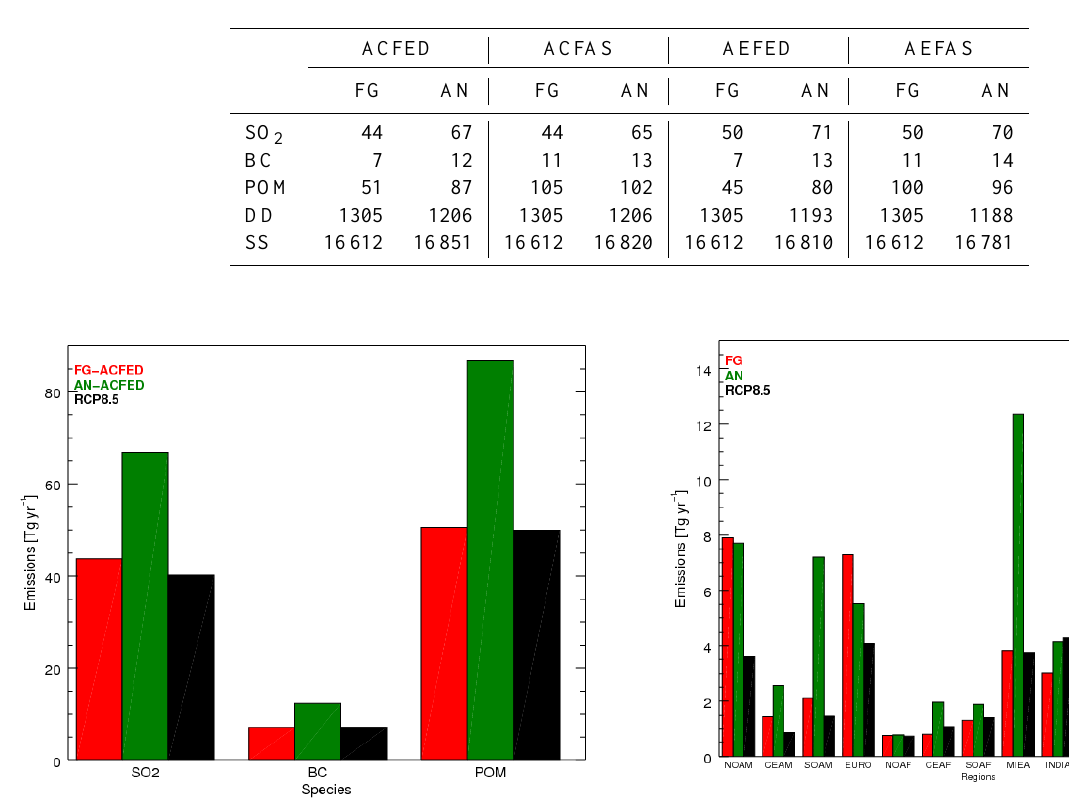
Fig. 4. Same as Fig. 3 but for annual SO 2 emissions in the thirteen regions illustrated in Fig. 1a.